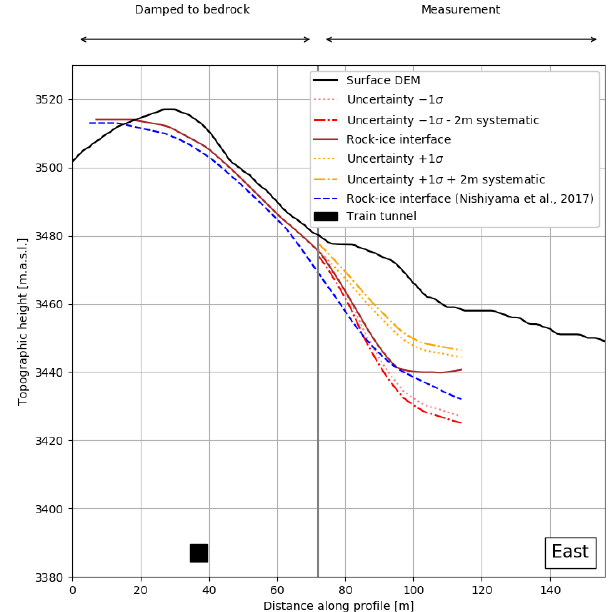
Figure 8. Eastern cross section. The brown and dashed blue lines indicate the ice–bedrock interface solutions of this study and the one from Nishiyama et al. (2017), respectively. The 1 σ error margins are shown in yellow (upper) and red (lower). The dotted margins encompass only the statistical variation of the interface position, whereas the dash-dotted margins include a ± 2m systematic error which stems from the inherent DEM uncertainty. For completeness, we also show the position of the railway tunnel as a black